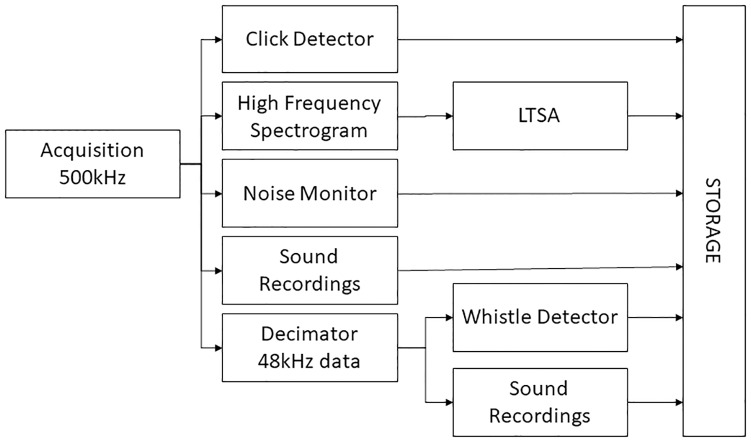
Block diagram of PAMGuard processing chain.